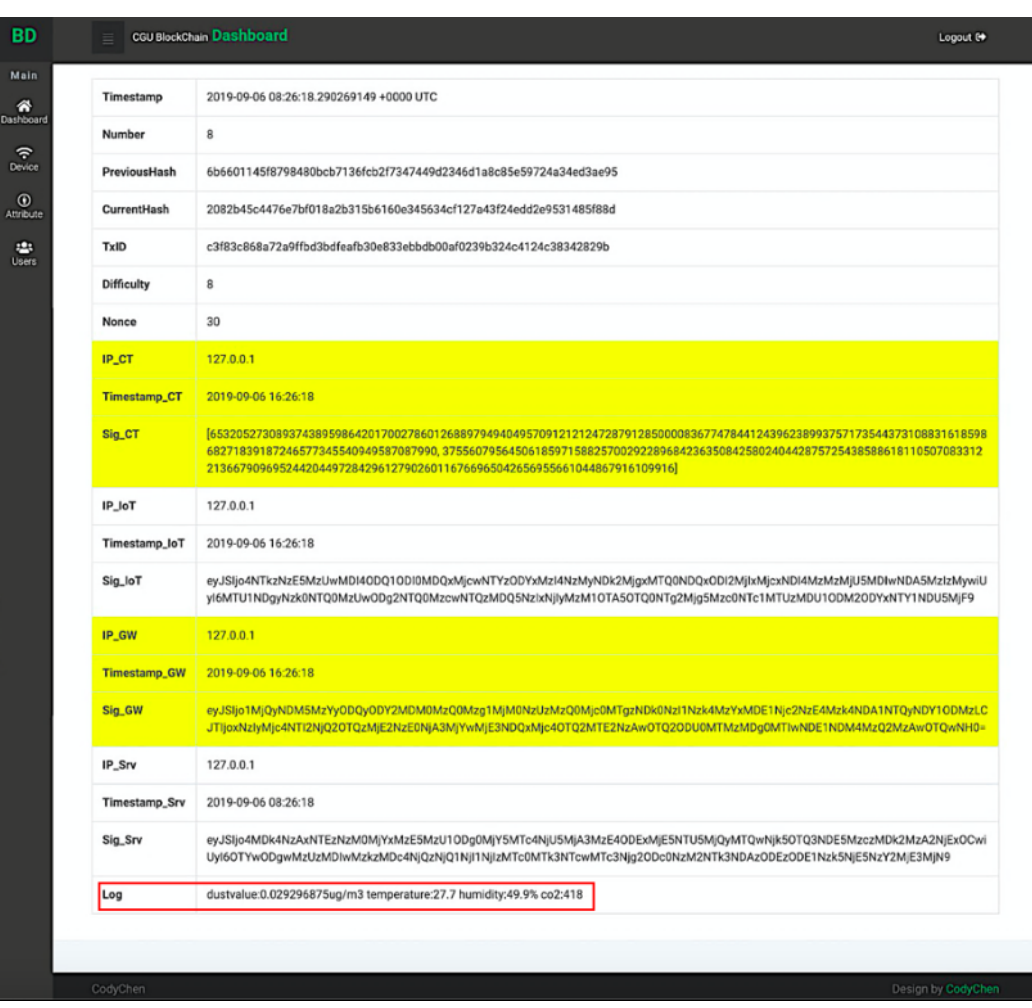
Figure 4. This is a figure. Figure 17. Data stored in a private